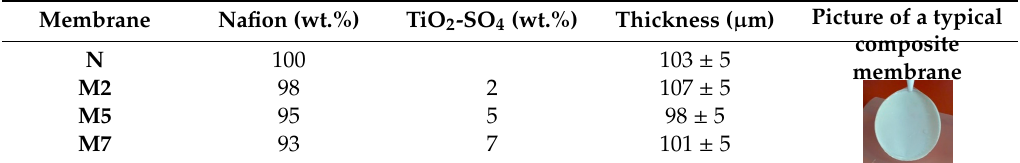
Table 1. Composition and thickness of the investigated membranes.